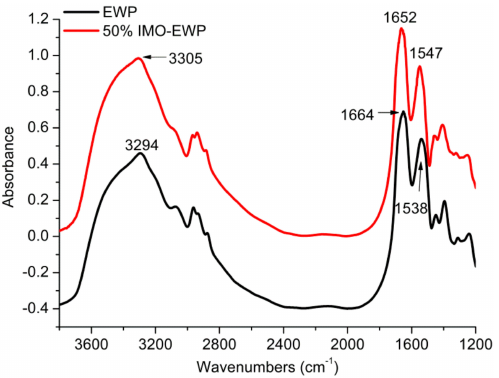
Figure 2. Fourier transform infrared spectroscopy (FTIR) spectra of EWP and 50% IMO-EWP conjugate at pH